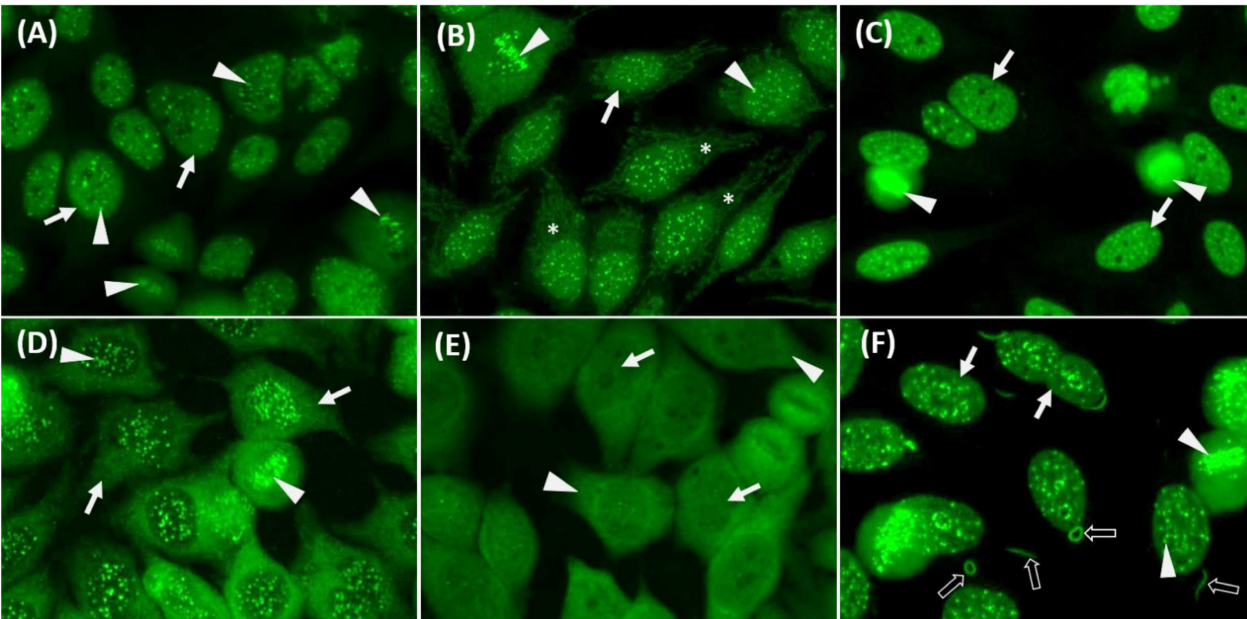
Figure 2. Examples of immunofluorescence mixed patterns on HEp-2 ANA images (INOVA, San Diego, CA, USA). ( A ) mixed centromere (arrowhead)and nuclear fine speckled patterns (arrow); ( B ) mixed centromere (arrowhead), nuclear fine speckled (arrow) and cytoplasmic AMA patterns (asterisk); ( C ) mixed nuclear homogenous (arrowhead) and nuclear large/coarse speckled patterns (arrow); ( D ) mixed centromere (arrowhead)and cytoplasmic speckled patterns (arrow); ( E ) mixed nuclear fine speckled (arrow) and cytoplasmic speckled patterns (arrowhead); ( F ) mixed nuclear fine speckled (arrow), centromere (arrowhead)and cytoplasmic rods and rings (black arrow)